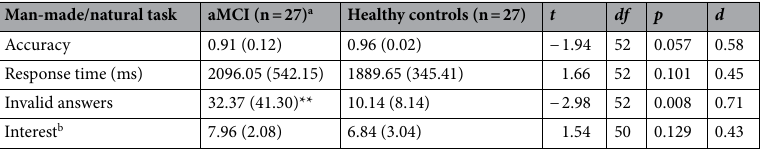
Table 1. Mean (standard deviation) accuracy, response time, invalid answers and interest ratings for the man- made/natural task in participants with aMCI and healthy controls, and results of independent samples T-test. aMCI amnestic Mild Cognitive Impairment. Differences between aMCI and HC are indicated by ** p < 0.01. a Except for the interest ratings that were not provided by two participants (one in each group). b Task interest ratings were made on a 10-point scale (1 = very boring; 10 = very